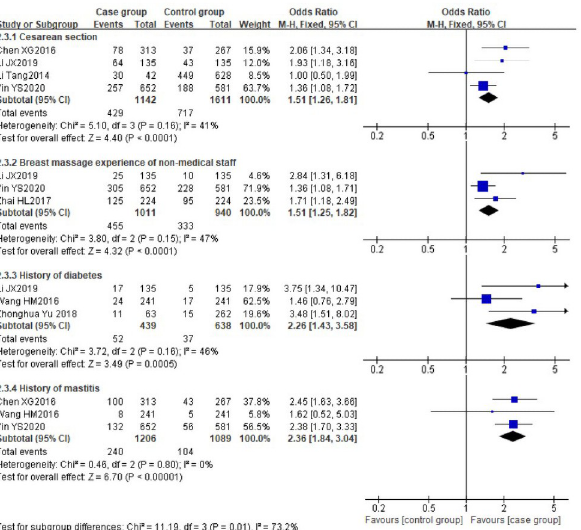
Fig 4. Forest plot comparing the pooled risks of cesarean section, breast massage experience of non-medical staff, history of diabetes and history of mastitis.